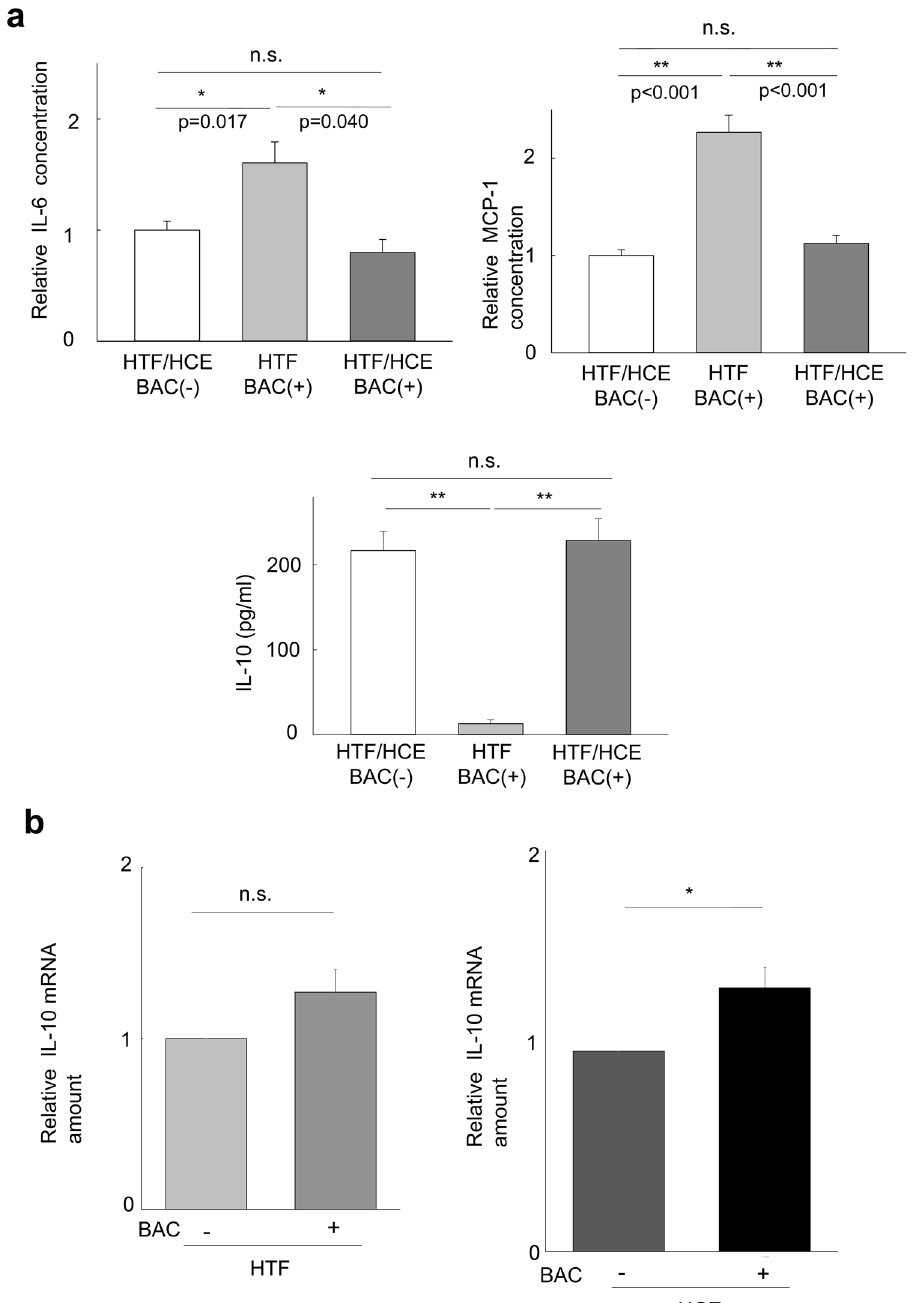
Figure 4. Effects of BAC on cytokine release in an HTF/HCE cell coculture system. ( a ) HTFs cultured in hanging mesh inserts of six-well plates containing (or not) HCE cells were deprived of serum for 24 h and then incubated in the absence or presence of BAC (5 × 10 −6 %) for 24 h, after which the levels of IL-6, MCP-1, and IL-10 in culture supernatants of the HTFs were measured. Data are means + s.e.m. for four independent experiments. * p < 0.05, ** p < 0.01, n.s. (Holm-Sidak post hoc test). ( b ) HTFs and HCE cells were cocultured and treated as in ( a ), after which the abundance of IL-10 mRNA in the two cell types was determined by RT-qPCR analysis. Data were normalized by the amount of GAPDH mRNA, and the normalized values were expressed relative to that for the corresponding cells incubated without BAC. Data are means + s.e.m. for three independent experiments. * p < 0.05, n.s. (Student’s t